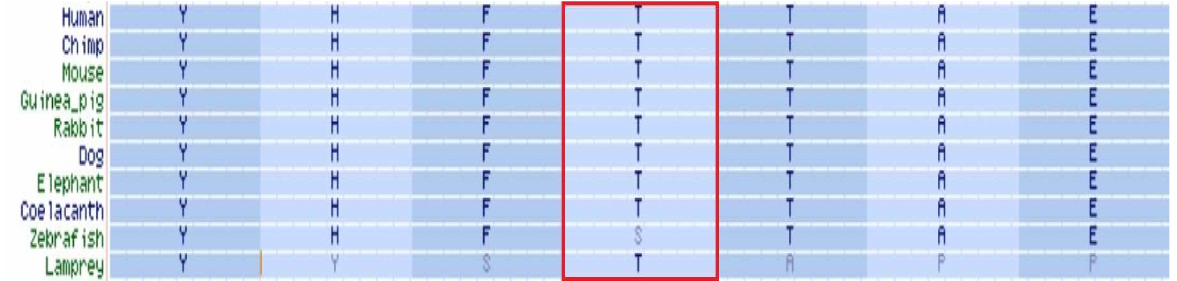
Figure 2. BCKDK orthology. Threonine in position 334 of BCKDK protein is marked by a red frame.